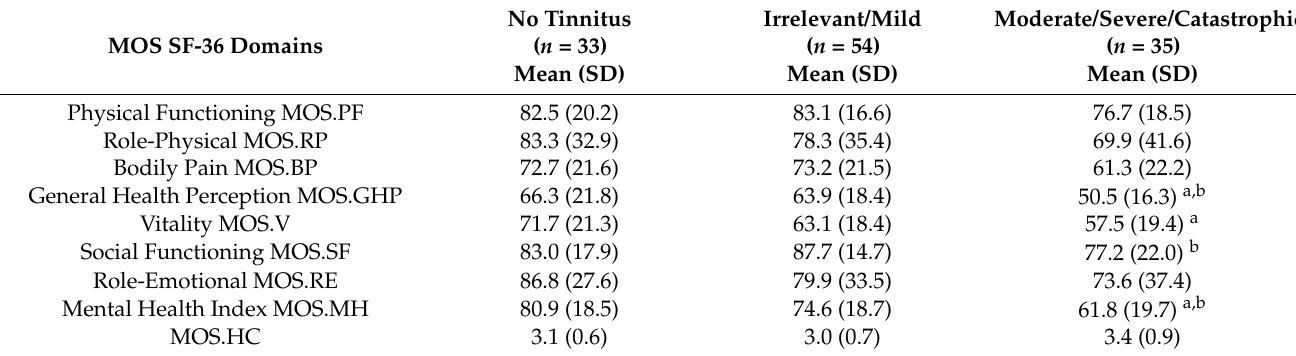
Table 8. Mean and standard deviation of MOS SF-36 scores for the three groups of tinnitus severity and results of pairwise